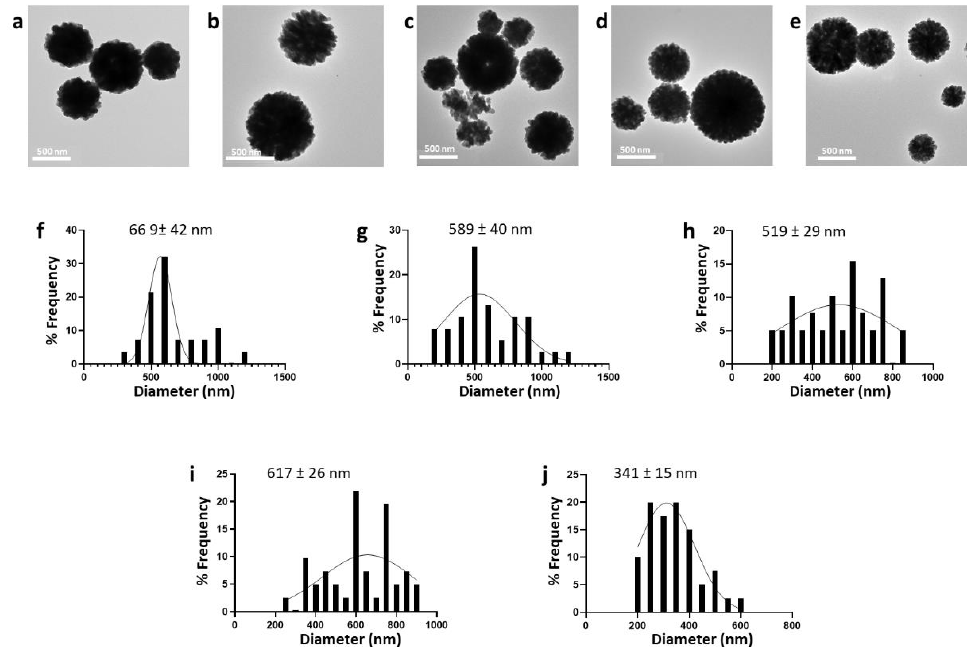
Figure 2. TEM images ( a – e ) and relative size distribution ( f – j ) of CaCO 3 NPs prepared by coprecipita- tion using different stirring rates, such as 625 rpm ( a , f ), 750 rpm ( b , g ), 875 rpm ( c , h ), 1000 rpm ( d , i ), 1125 rpm ( e , j ).